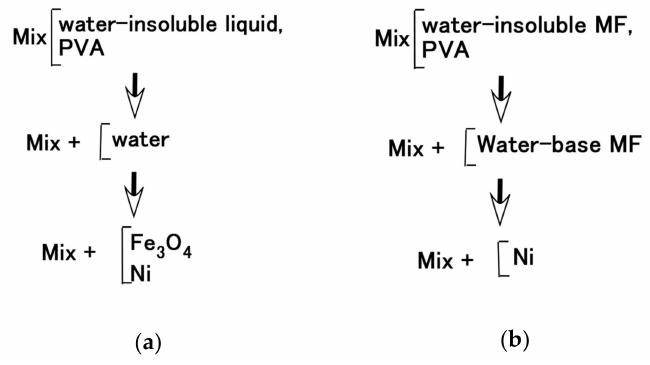
Figure 4. Images of liquid mixed water-insoluble MF and water-based MF: ( a ) kerosene-based MF mixed without a magnetic field; ( b ) kerosene-based MF mixed under a magnetic field; ( c ) alkyl naphthalene-based MF mixed without a magnetic field; ( d ) alkyl naphthalene-based MF mixed under a magnetic field.